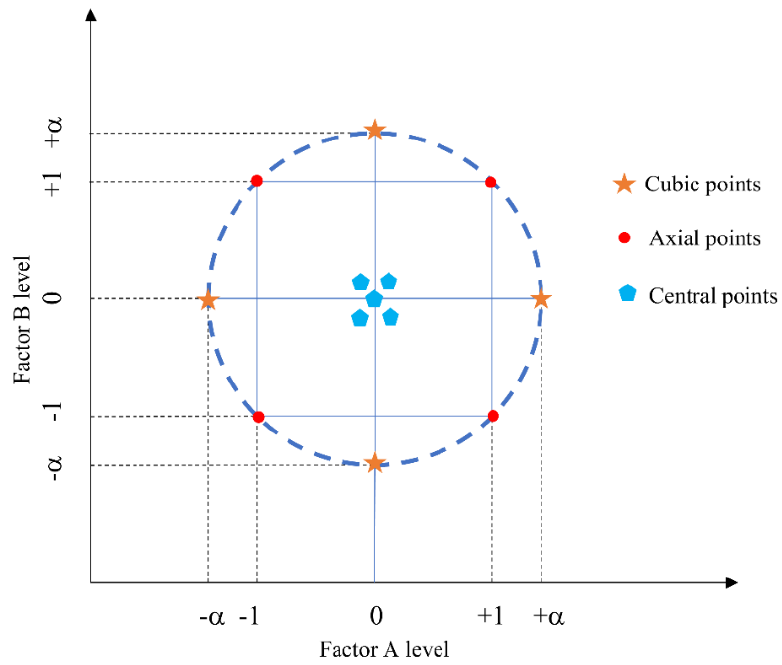
Figure 11. Point distribution diagram for CCD test.